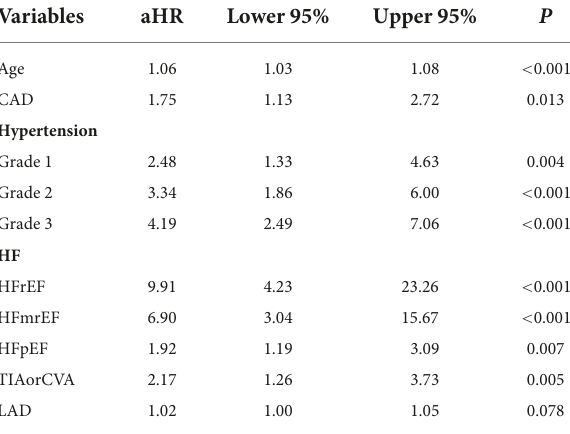
TABLE 1 Patients characteristics of the development and validation cohorts. Variables Development cohorts